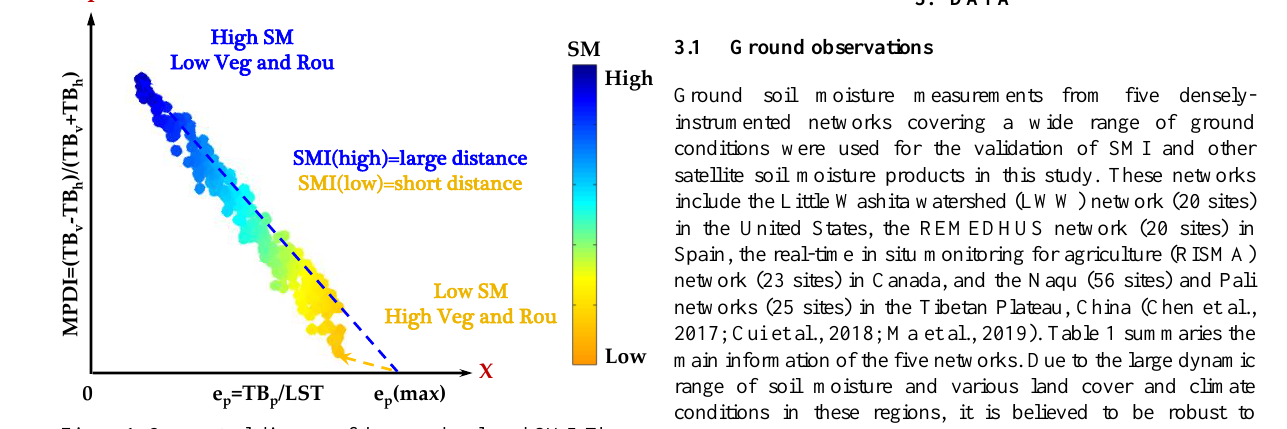
Figure 1. Conceptual diagram of the new developed SMI. The distance originated from e p (max) point on the x-axis to the scatter denotes the SMI value. The slanting yellow line denotes a small SMI indicating that SM is low, while the slanting blue line denotes a large SMI indicating that SM is high.